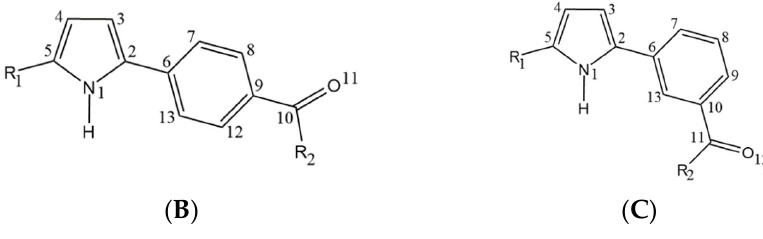
( b ) Figure 9. Dependencies of the l (C 2 ‒ C 6 ) and l (C 7 ‒ C 8 ) bond length on − E π (PPE) ( a ) and l (C 6 =C 7 ) and l (C 8 =O 9 ) bond length on − E π (PPE) ( b ) for subseries Ia and b of the studied compounds. The C 2 ‒ C 6 , C 7 ‒ C 8 , C 9 ‒ C 10 , and C 12 ‒ C 13 bonds are shortened, the C 6 ‒ C 7 , C 8 ‒ C 9 , C 10 =O 11 , C 9 ‒ C 12 , and C 6 ‒ C 13 bonds (see structure B in Scheme 4) are lengthened with the − E π (PPE) increasing in subseries IIa and b (negative A coefficient in Equations (S4), (S6), (S8), (S11), (S13), (S15), (S17) and (S19), positive A coefficient in Equations (S5), (S7), (S9), (S10), (S12), (S14), (S16) and (S18), Table S69). The C 2 ‒ C 6 , C 7 ‒ C 8 , and C 10 ‒ C 11 bonds are shortened, the C 6 ‒ C 7 , C 8 ‒ C 9 , C 9 ‒ C 10 , C 10 ‒ C 13 , and C 6 ‒ C 13 bonds (see structure C in Scheme 4) are length ‐ ened with the ‒ E π (PPE) increasing in subseries IIIa (negative A coefficient in equations (S21), (S23), and (S26), positive A coefficient in Equations (S22), (S24), (S25), (S27), and (S28), Table S69). The C 2 ‒ C 6 , and C 10 ‒ C 11 bonds are shortened with the − E π (PPE) increasing in subseries IIIb (negative A coefficient in Equation (S29) and (S30), Table S69). No corre ‐ lation of other bond lengths with the − E π (PPE) value is observed in subseries IIIb . It should be recalled that there are no single and double bonds inside the phenyl ring due to the electronic delocalization. 2.9.2. Dependence of C=O Vibration Frequency on − E π (PPE) Value